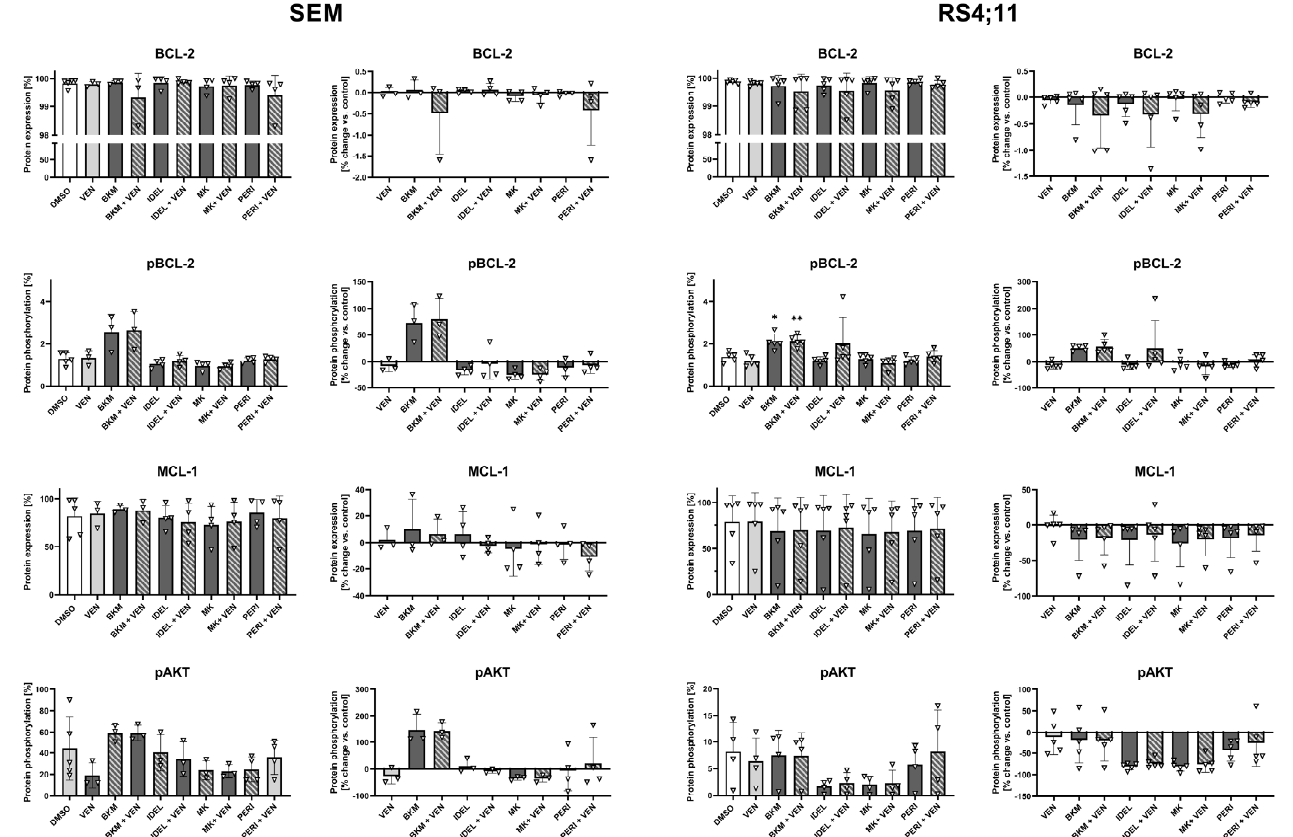
Figure 3. Detection of protein expression and activity using intracellular flow cytometry. Cells were incubated with VEN and PI3K/AKT inhibitors for 48 h. Representation of the absolute protein expression/phosphorylation (left graphs) indicating the amount of target-positive cells within the entire cell population. The relative proportion of positive cells compared to control cells was calculated within each replicate and is represented in the right graphs (n ≥ 3; ANOVA and post-hoc Tukey’s multiple comparison test, * p < 0.05, ** p < 0.005).